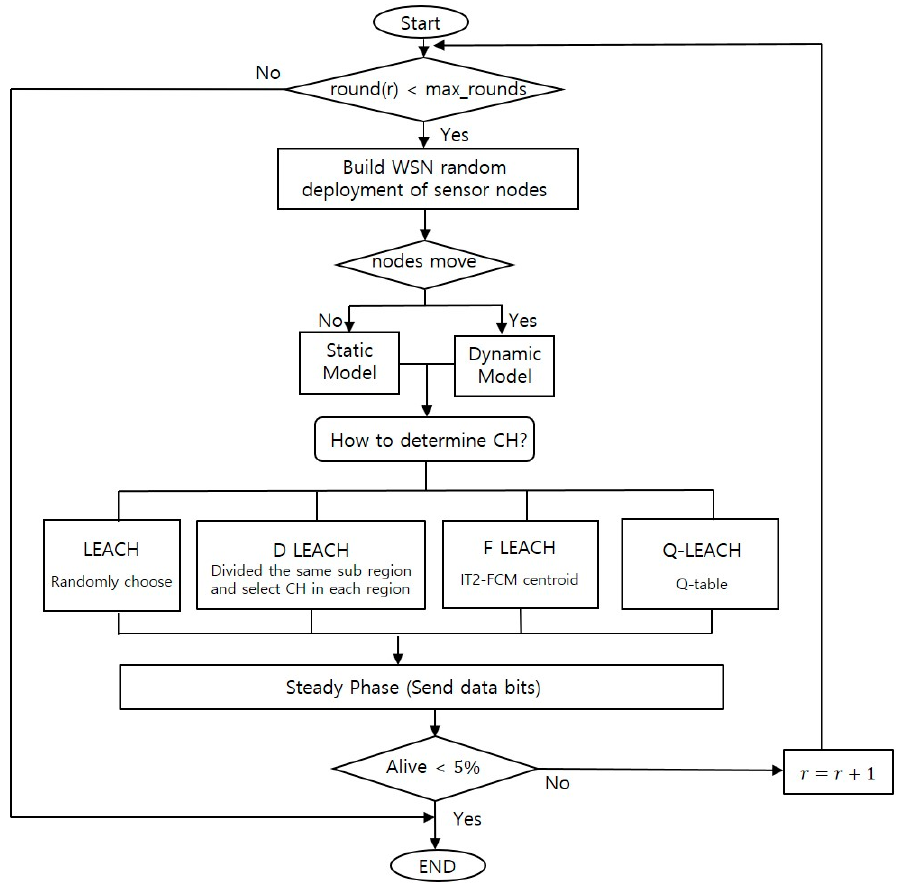
Figure 6. Workflow of research.